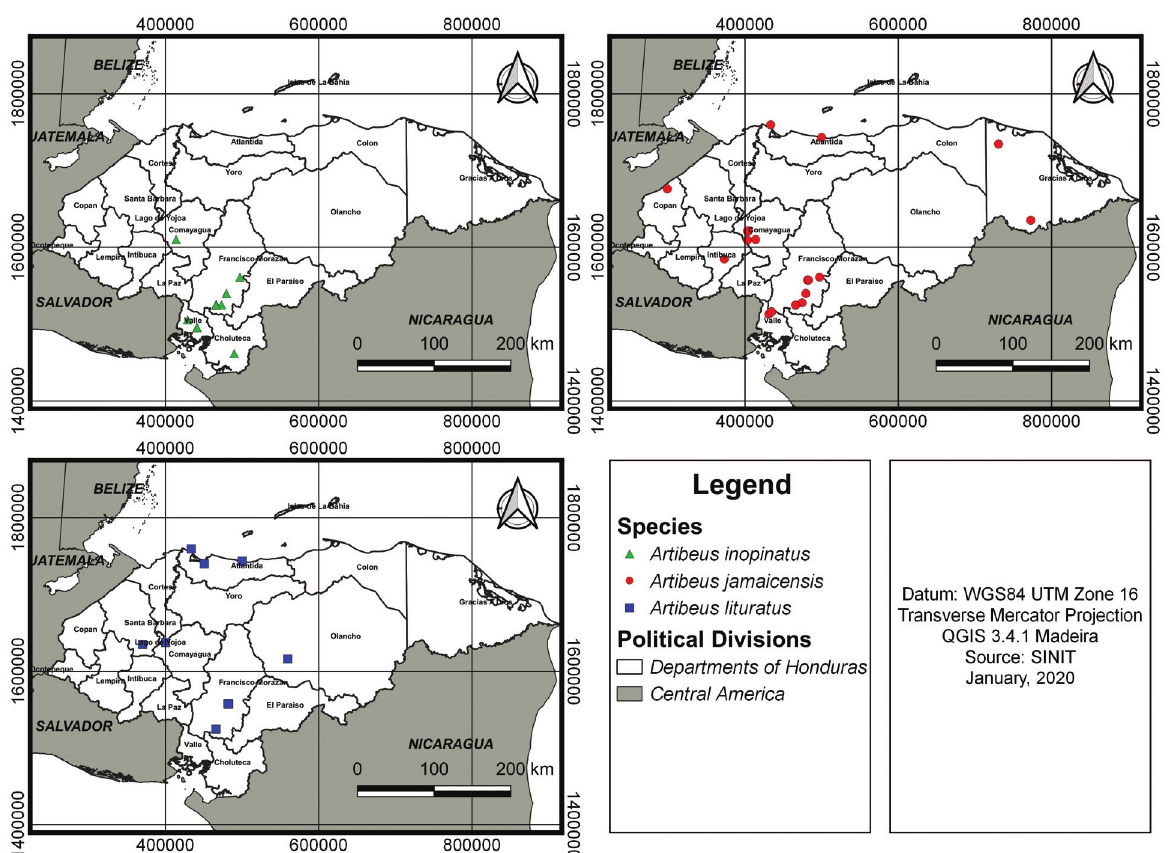
Figure 1. Localities in which the three species of Artibeus were recorded from February 2015 to September 2019. Notice the extension of the distribution of A. inopinatus to different localities in northern Francisco Morazán and Comayagua. These records represent a distribution extension because it was only known in southern Honduras including El Paraíso (GBIF.org